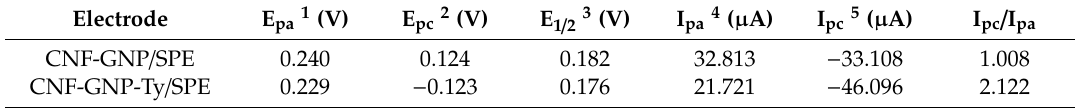
Table 4. The values of the parameters obtained from the cyclic voltammograms of all the electrodes